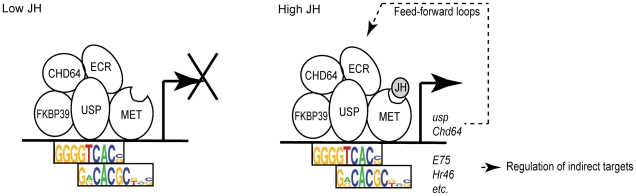
Model for usp regulation of behavioral maturation.According to this model, USP mediates responses to JH as part of a complex of proteins – pre-assembled at the promoters of JH-responsive genes – that likely includes USP, MET, EcR, Chd64, and FKBP39; all of these TFs have been shown to physically interact with one another in vitro
[24], [64]. Low JH titers (nurse bees) lead to target gene repression. High JH titers (foragers) cause target gene activation. This might occur via ligand-dependent conformational changes in the protein complex and recruitment of general transcriptional machinery, both of which are known for USP in other contexts [53] (not shown). JH most likely binds MET, the only TF in this complex known to have strong affinity for JH [63]. The model also suggests the presence of a feed-forward loop [10] that stabilizes responses to JH; this role could be played by two components of the JH signaling complex – usp and Chd64 – themselves USP targets. Other TFs among USP targets – including TFs previously implicated in JH signaling such as E75 and Hr46
[25] – are available to propagate these responses to indirect targets of USP and JH. This model can explain differential gene expression caused by both USP and JH despite the fact that USP was found to bind the same genomic locations in the fat bodies of nurses and foragers. It also is consistent with findings that these genomic locations are enriched for two very closely located (3 bp apart) cis-regulatory motifs, one recognized by USP and the other recognized by bHLH TFs, including MET.